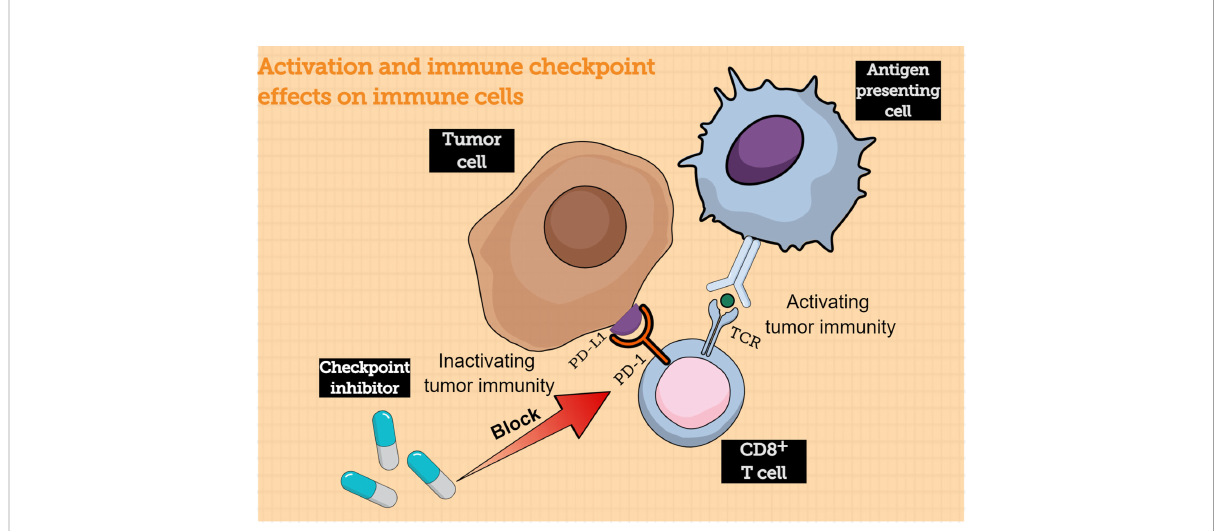
FIGURE 1 Activation of immune-checkpoint effects on immune cells. The CD8+ T cells can be activated by interacting with antigen-presenting cells, following which the CD8+ T cells can acquire the capacity to kill tumor cells. However, tumor cells express immune checkpoint proteins that bind to receptors on the surface of CD8+ T cells to evade immune cells; immune checkpoint inhibitor can block this process, thereby allowing CD8+ T cells to kill tumor cells. TCR, T cell receptor; PD-1, programmed cell death protein 1; PD-L1, programmed cell death ligand